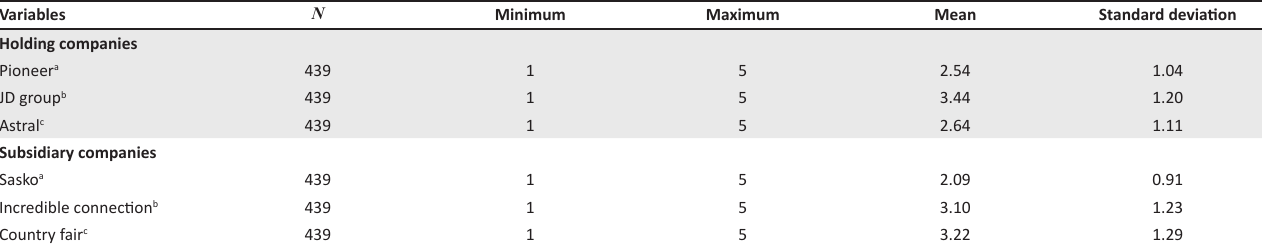
TABLE 5: Descriptive statistics: Holding company versus subsidiary company. Variables N Minimum Maximum Mean Standard